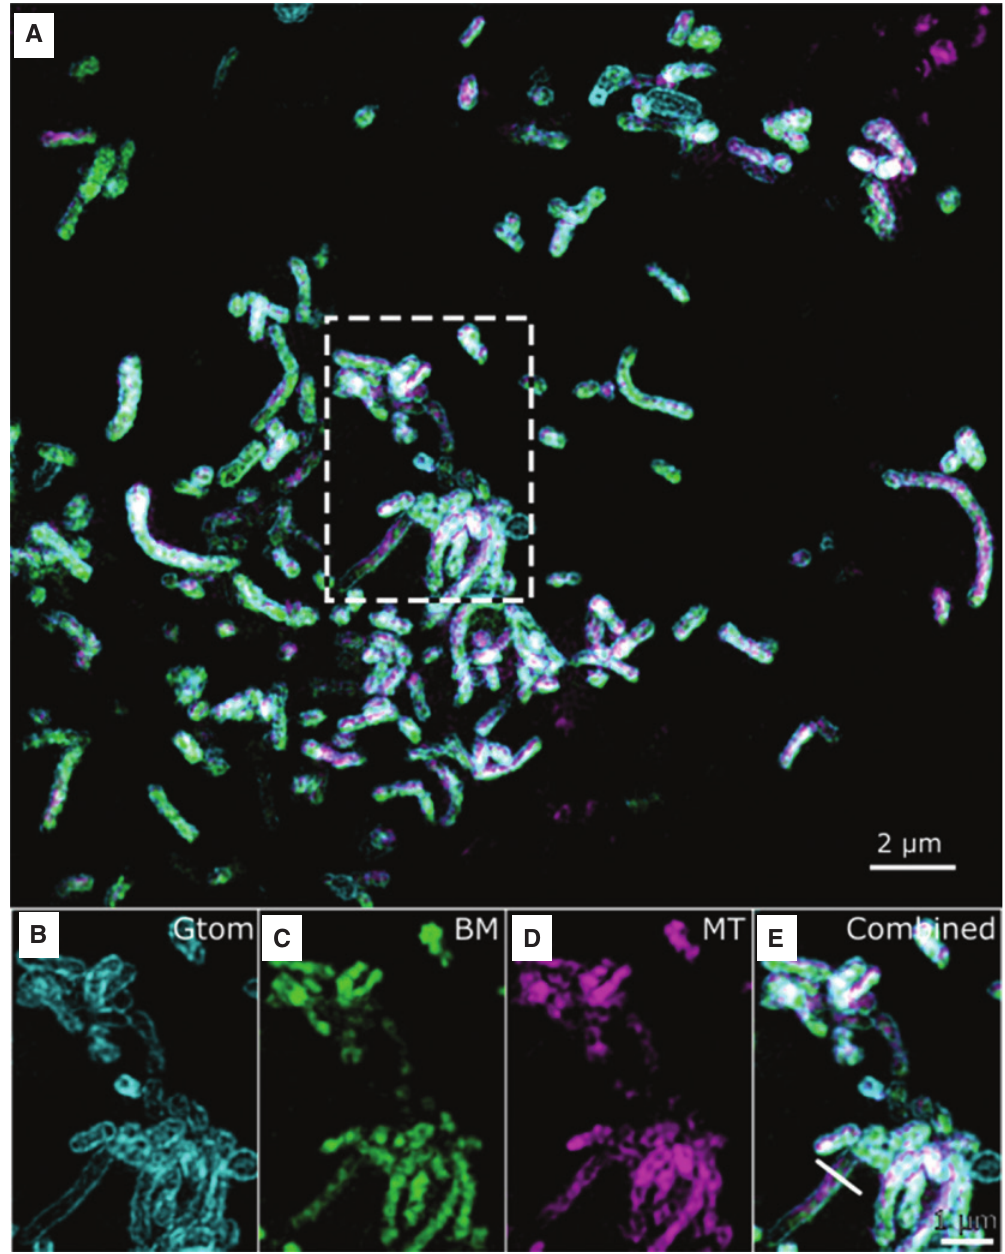
Figure 5: Live imaging of MCC13 cells triple labeled with Gtom, BM, and MT. The indicated region in (A) is shown magnified below with separate (B) Gtom, (C) BM, (D) MT, and (E) merged color channels. Images are maximum intensity projections of a 1- μ m 3D SIM z-stack. The line profile indicated in (E) is plotted in Figure 6, and Fourier plots with resolu- tion estimates of these 3D SIM images are found in Supplemental Figure